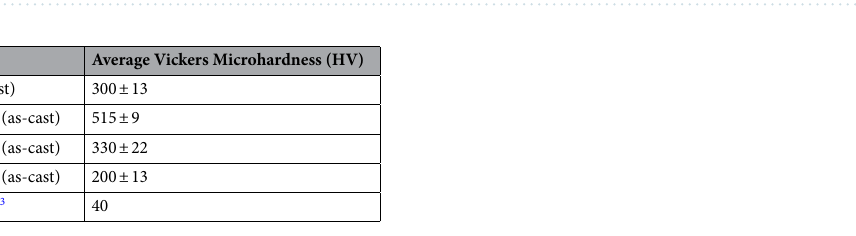
Table 2. Vickers microhardness of as-cast Ti-5Mo-XNb and cortical bone.